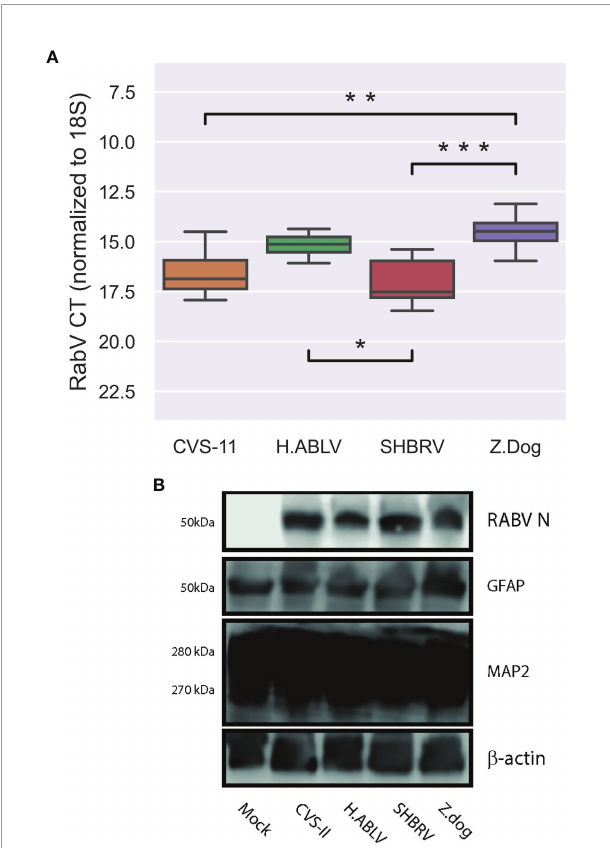
FIGURE 1 | Lyssavirus infection of human stem cell derived neural cultures. (A) Boxplot of lyssavirus N protein RNA expression in CVS-11 (orange, n = 11), H.ABLV (green, n = 12), SHBRV (red, n = 10), and Z.Dog (purple, n = 12) infected HDF51i-509 neural cell cultures following 25-32 days in vitro differentiation. All sample numbers are technical replicates obtained from three separate biological experiments. Boxes are the 25th - 75th percentile, line is the median, and whiskers are 1.5x IQR. * p-value < 0.05, ** p-value < 0.01, *** p-value < 0.001. (B) Immunoblot of lyssavirus infection (RABV N protein)